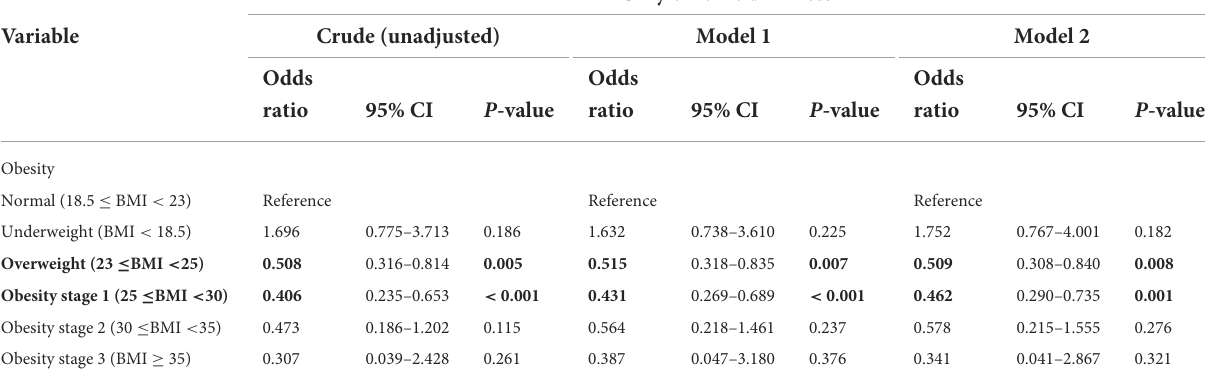
TABLE 5 Logistic regression analysis for chronic dizziness according to the body mass index.